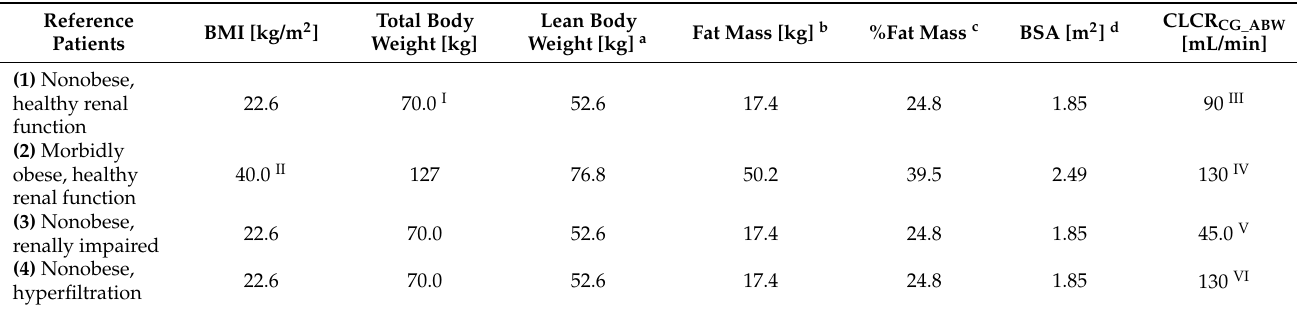
Table 1. Virtual reference patients of the same standard body height (1.76 m) and sex (male) but different obesity stage and renal